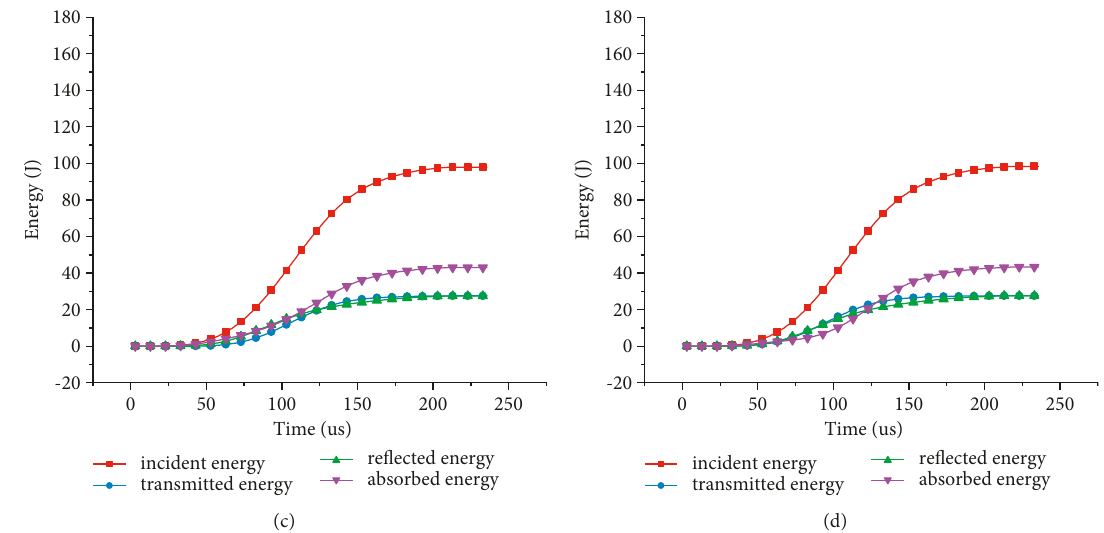
Figure 8: Energy time history curve of impact compression test. (a) Impact velocity 12.60m/s. (b) Impact velocity 12.07m/s. (c) Impact velocity 10.79m/s. (d) Impact velocity 9.78m/s.